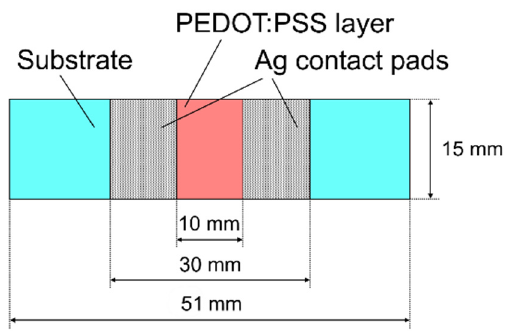
Figure 1. Layout of tested samples.